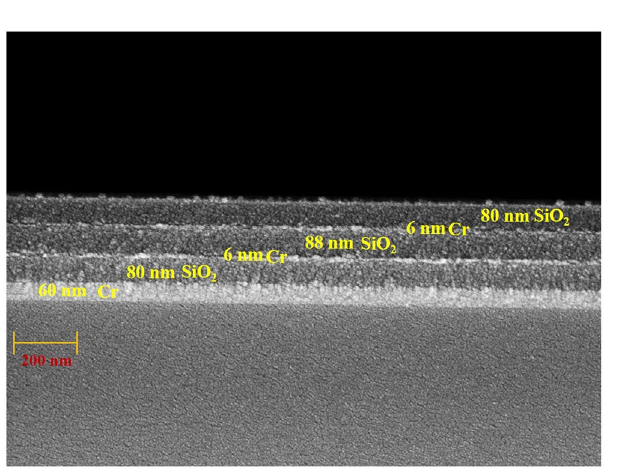
Figure 4. ( a ) Equivalent admittance and ( b ) refractive index of the five-layered metamaterial versus wavelength.